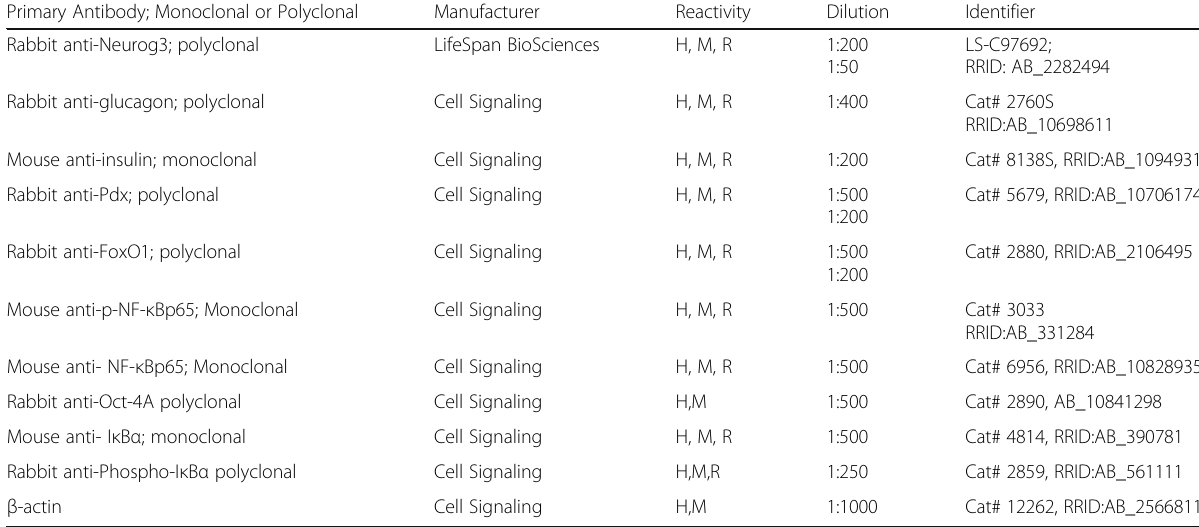
Table 1 Antibodies used in this study Primary Antibody; Monoclonal or